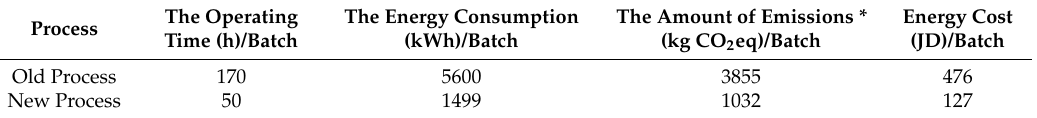
Table 3. The energy consumed and emissions comparison in old process and new process.